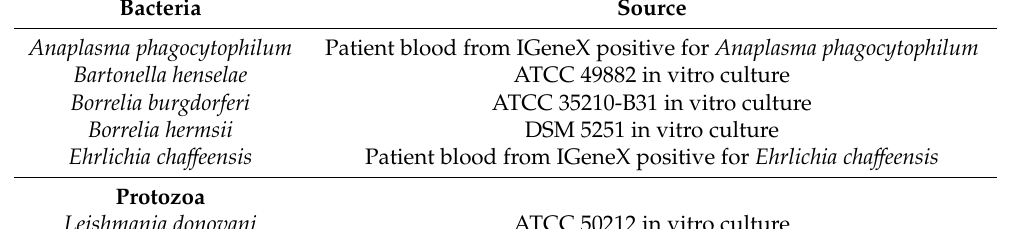
Table 1. Reference pathogens tested in the Babesia genus fluorescence in situ hybridization (FISH) test.